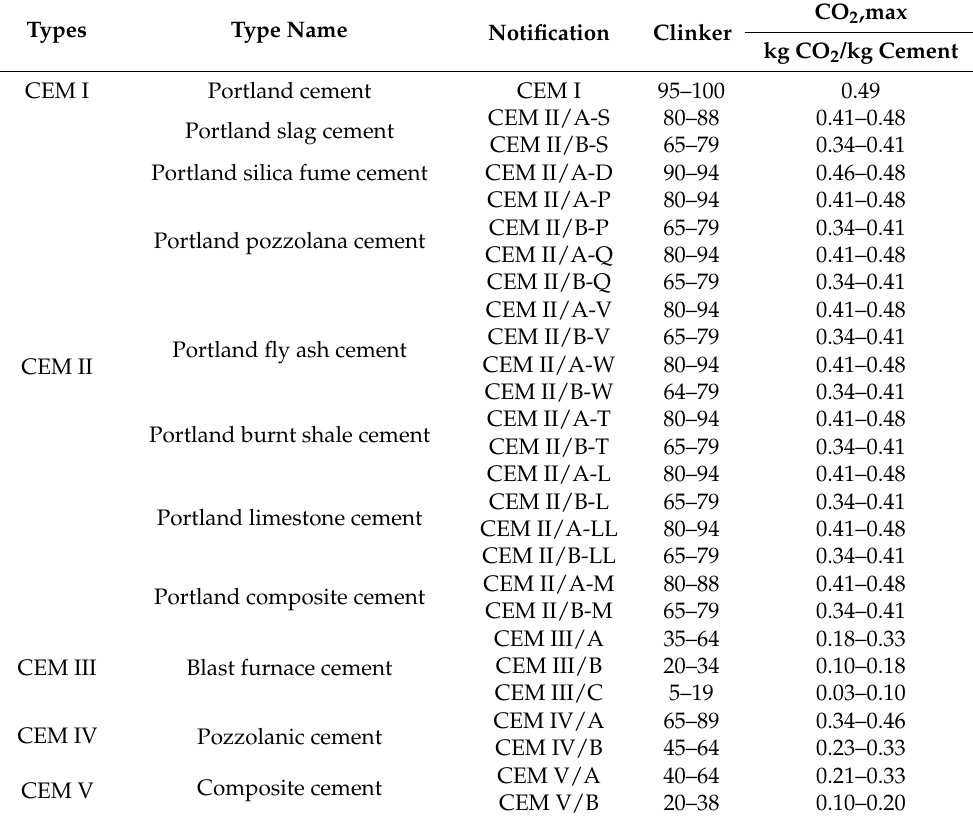
Table 1. Maximum amount of carbon dioxide that different EN 197-1 cement can absorb, adapted from Sanju á n et al.